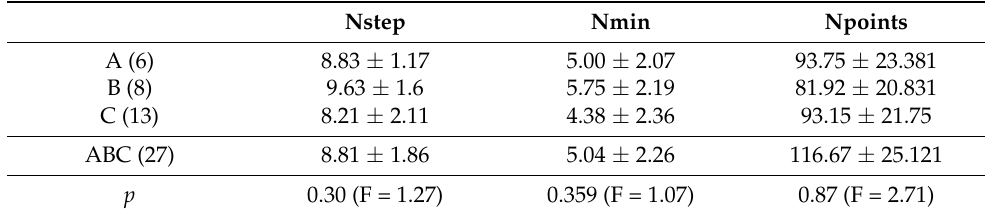
Table 4. ANOVA 1-way on number of workload increments (Nstep), number of minima (Nmin), and number of points of HR time series